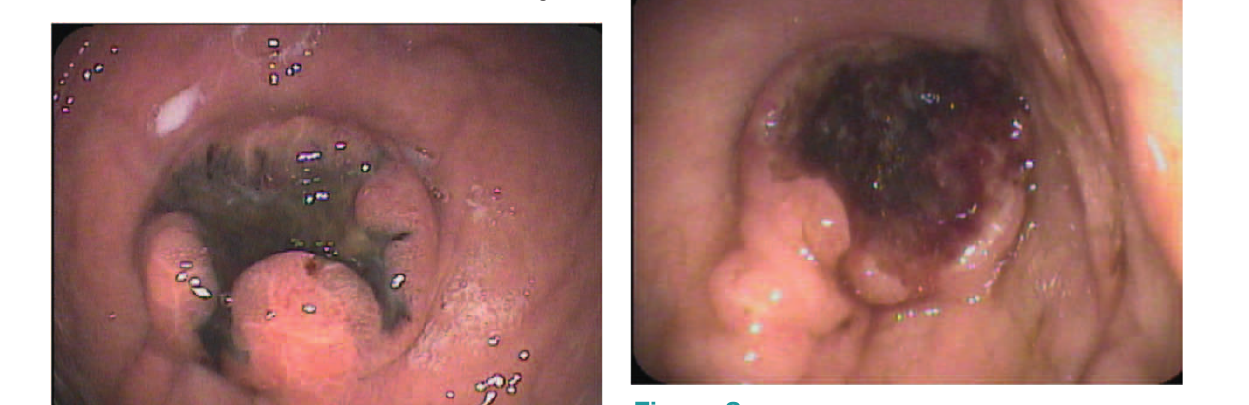
Figure 3. Metastatic lesion of the lungadenocarcinoma in the antrum with ulceration at the tip